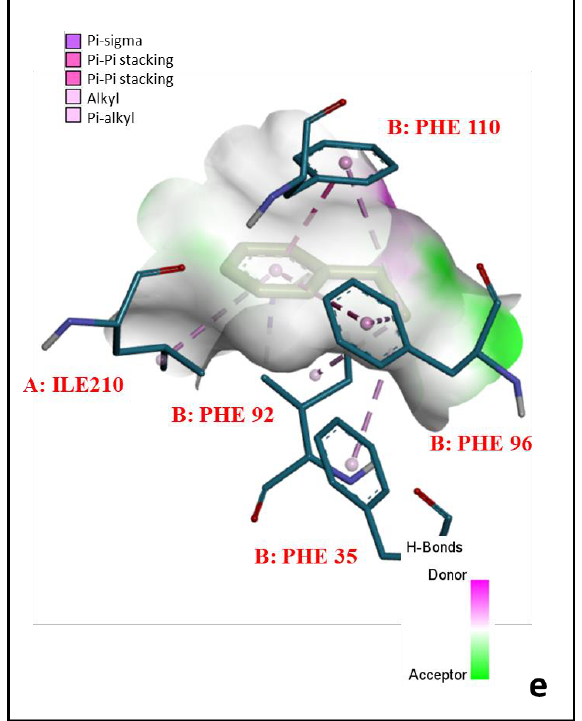
Figure 8. The interactions between ethylbenzene and ( a ) B:Leu31Ser, ( b ) B:Phe96Gly, ( c ) B:Phe92Thr, ( d ) B:Trp106Ala, and ( e ) B:Tyr110Phe. The Ramachandran plots analyzed for the suitable mutants (B:Leu31Ser, B:Phe96Gly, B:Phe92Thr, B:Trp106Ala, and B:Tyr110Phe) describe the changes in stereochemical prop-